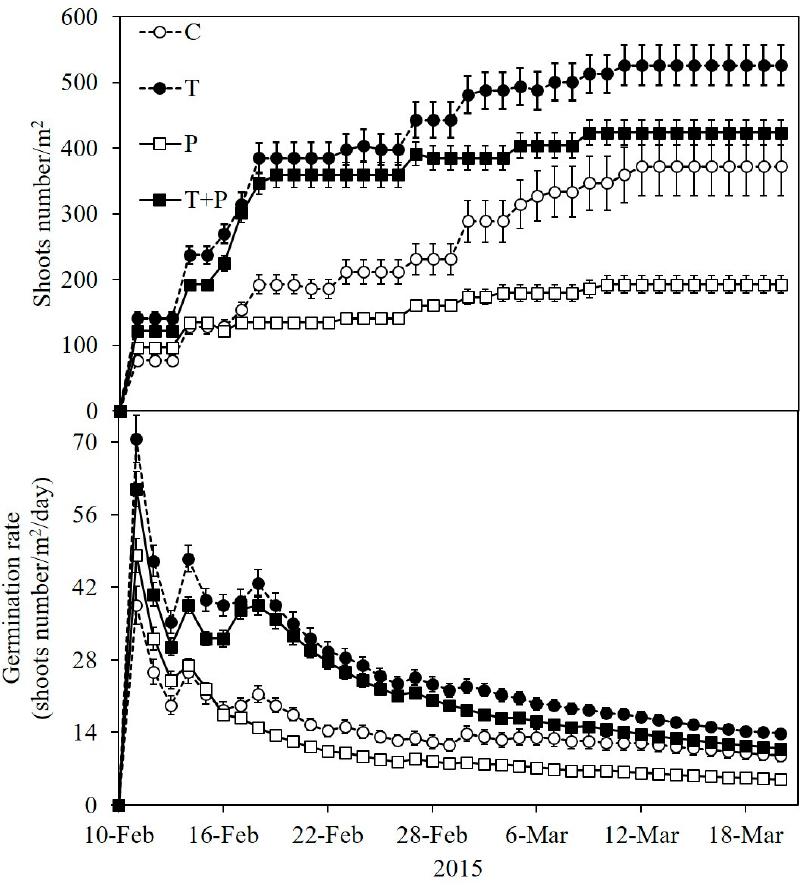
Figure 5. The average number and germination rate of P. crispus shoots during the experiment in 2015. Error bars indicate ± standard error (SE). For abbreviations used, see Figure 2.